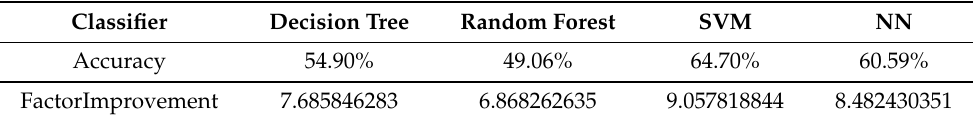
Table 3. Performance of different algorithms at classifying cell e-type (14 classes, 7.143% equivalent random guessing